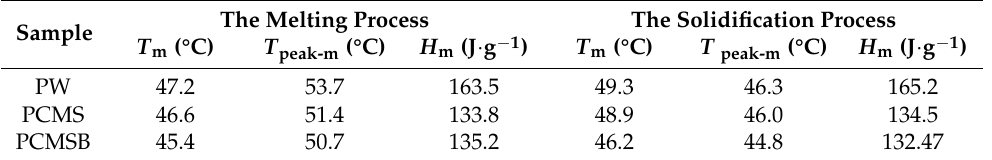
Table 5. Thermophysical properties obtained from the DSC